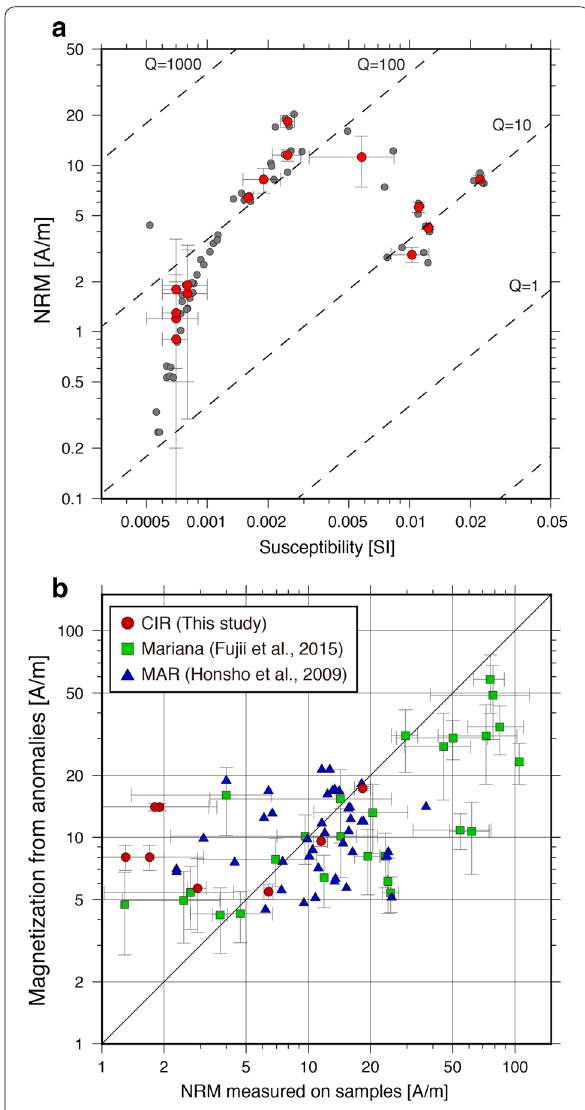
Fig. 8 a Log–log plot of magnetic susceptibility ( K ; SI) and natural remanent magnetization (NRM; A/m) of basaltic lava samples collected near the Kairei and Yokoniwa hydrothermal fields of the Central Indian Ridge. The broken lines show constant Q values (Koenigsberger ratio) calculated for a magnetic field of 45,000 nT. The red circles show averaged values with standard deviations in each lava sample and the gray circles show each measured value for all cubic specimens. b Comparison between reliable magnetic-anomaly-derived absolute magnetization (MADAM) with high coherency (> 0.5 and > 0.3 for 918R06) and NRM measured on rock samples. The applied MADAM corresponding to each rock NRM intensity was the average value near each rock sampling location (within 100 m). The error bars along the x - and y -axes show standard deviations of the NRM intensities and MADAM estimates for each point, respectively. The red circles show the data of the Central Indian Ridge (CIR) presented in this study. The green squares and blue triangles show previously reported data from the southern Mariana Trough (Fujii et al. 2015) and Mid-Atlantic Ridge (Honsho et al. 2009),